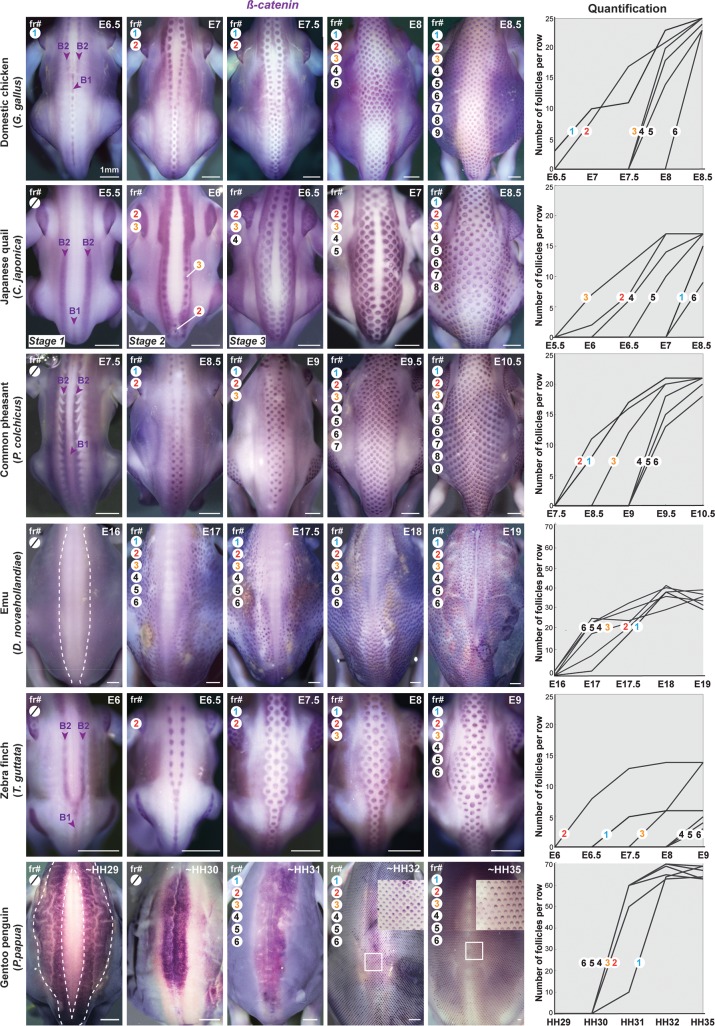
Dorsal tract formation varies in directionality, sequentiality, and duration.In situ hybridisations revealing β–catenin transcripts (in purple, left panels) mark the dynamic appearance of fr at equivalent developmental stages in each species (n values are listed in S1 Table). In the domestic chicken, the Japanese quail, the common pheasant, and the zebra finch, the first fr arise from three medial bands: one posteriorly located (B1) and two anteriorly located (B2). Lateral rows then appear one by one in a front that progresses ventrally and stops at the limit of the dorsal tract. In the emu, β–catenin is first seen throughout the dorsum but in a thick medial region (white dotted line); follicles then individualise progressively at random locations. In the gentoo penguin, two wide β–catenin–expressing lateral surfaces (white dotted line) precede a switch to the central region. Only then do follicles appear rapidly throughout both herein defined surfaces, creating a regular squared geometry (see magnifications, white squares). Automatic quantifications of F per row (right panels) show that fr#1–6 appear in a sequential manner in Galliformes and the zebra finch: follicle individualisation occurs in a given row when the preceding row is near completed (with the exception of fr#1, where it has species–specific timing, and fr#2 in the Japanese quail, where it is first restricted posteriorly). In contrast, along virtual longitudinal lines in the emu and the gentoo penguin (see S1 Fig), follicles individualise simultaneously with no apparent spatial order. The colonisation of the feather field lasts 2–3 days in Galliformes, and the zebra finch and is comparably faster in the emu and the gentoo penguin. HH stage 1, stage 2, and stage 3 are defined in Fig 5 and Fig 6; scale bars: 1 mm. E, embryonic day; fr, feather row; HH, estimated Hamburger and Hamilton stage.